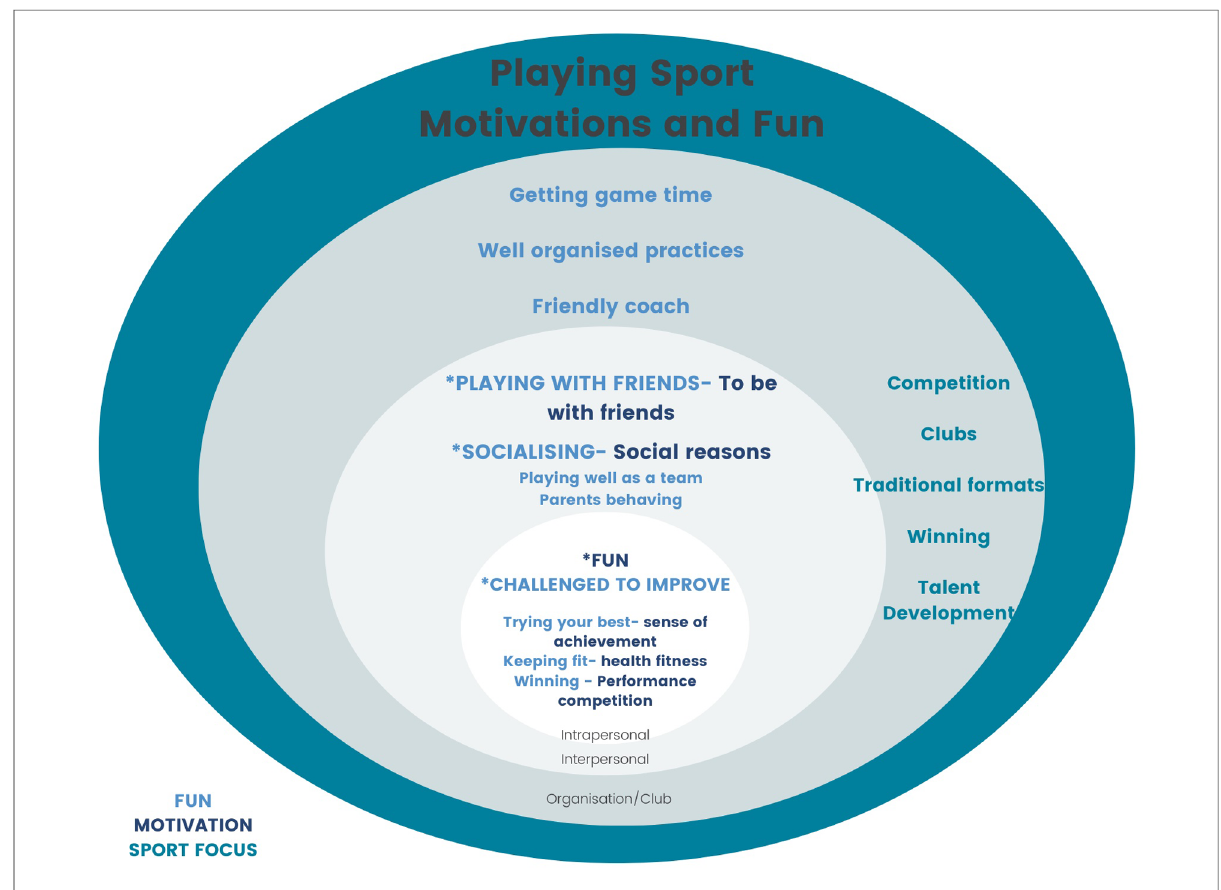
FIGURE 1 Sport structure, motivations and what makes playing